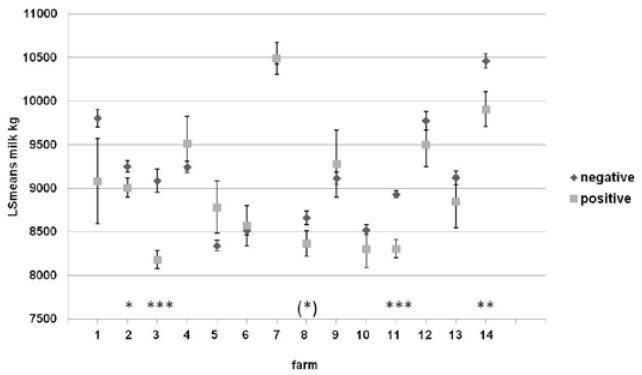
Figure 4 LS means for the milk per day of life in kg for the interaction between farm and paratuberculosis status tested by faecal culture (* P≤ 0.05, ** P≤ 0.01, *** P≤